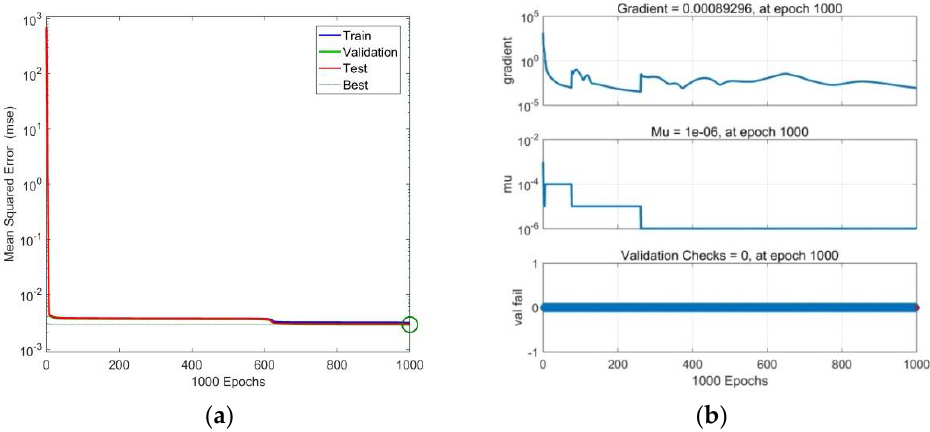
Figure 5. ( a ) Performance plots of the neural network model; ( b ) Training state plots of neural network model.